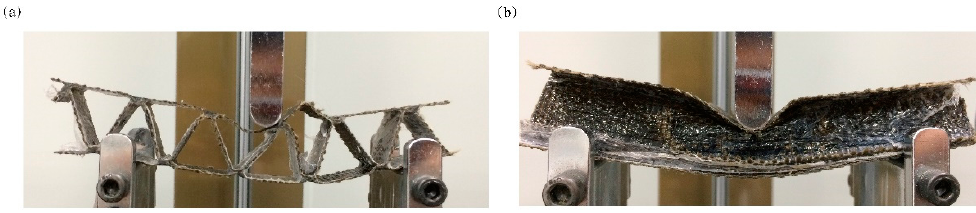
Figure 3. Tested results of ( a ) zigzag direction and ( b ) spacer wall direction.